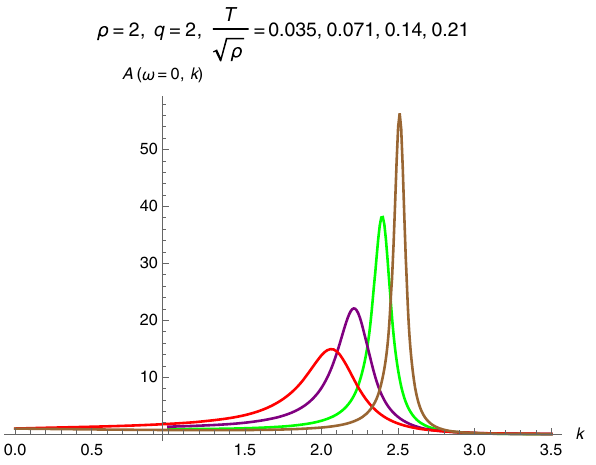
Fig. 4 A (ω = 0 , k ) vs. k with q ,ρ = 2 for different values of temper- √ ρ = 0.035 (Brown), 0.075 (Green), 0.14 (Purple) and 0.21 ature T /